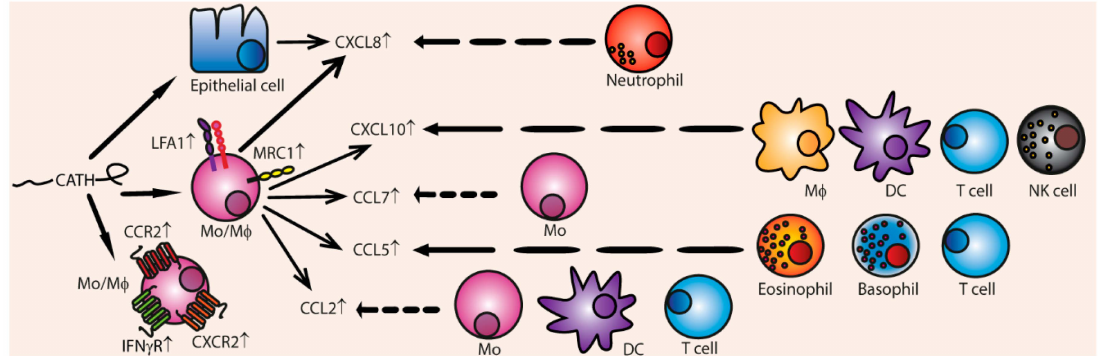
Figure 5. Cathelicidins indirectly induce chemotaxis by inducing the production of various chemokines and chemokines receptors. Cathelicidins can induce chemokine receptor production in monocytes of CCR2, CXCR2, IFN γ -R, MRC1, and LFA1. Additionally, stimulated monocytes produce CCL2, CCL5, CCL7, CXCL10, and CXCL8 (IL-8). Epithelial cells can also be induced to produce CXCL8. The main cell types responding to the chemokines are